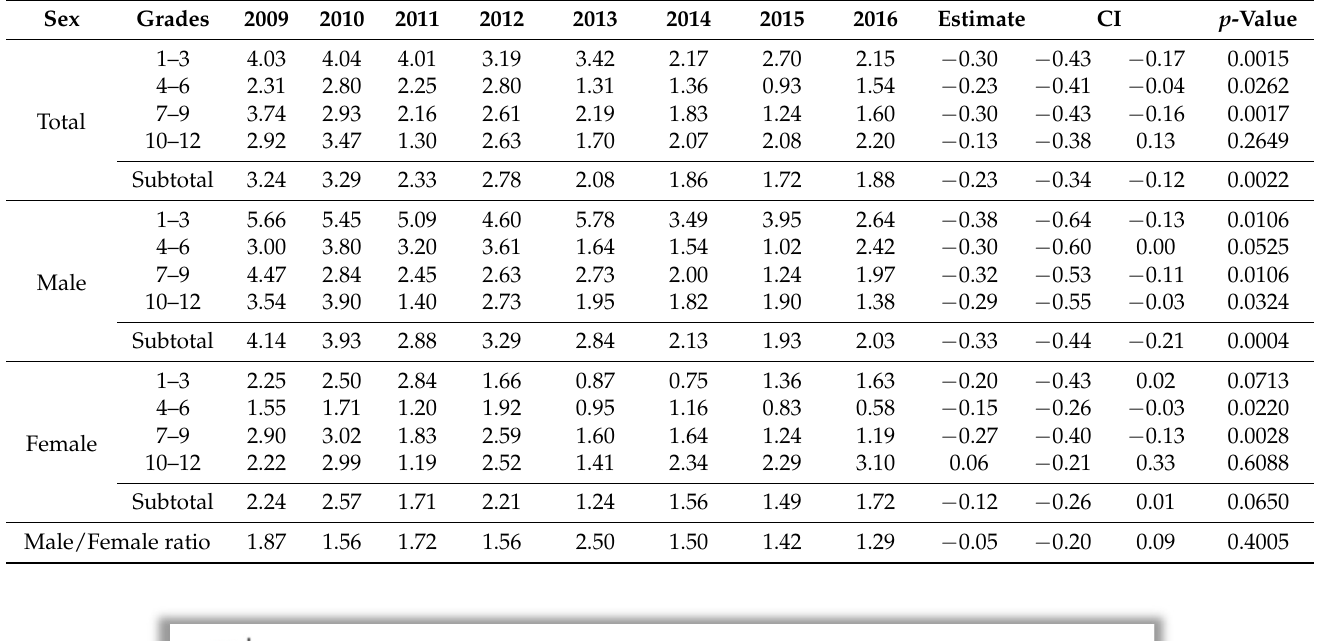
Table 1. Number of first-time patients according to year, gender, and grades (per 100,000).